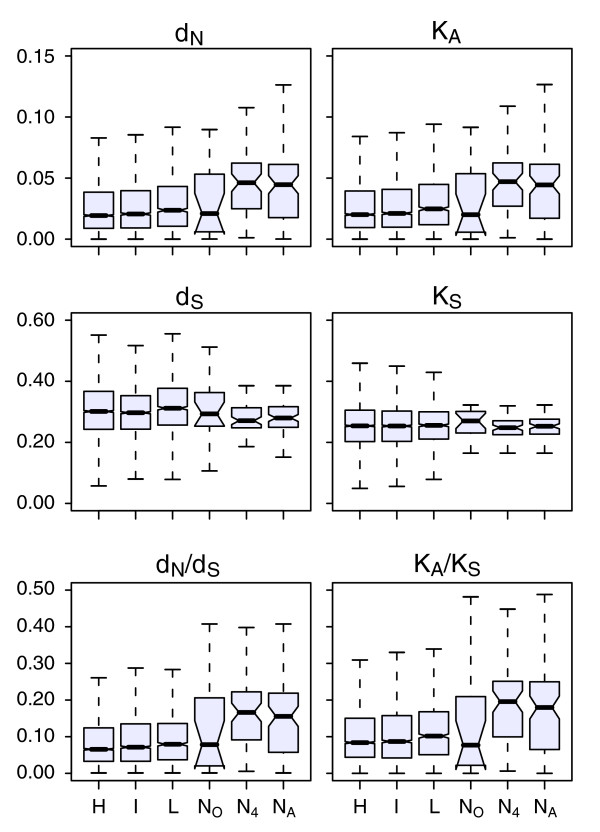
Notched box-plots of dN, dS, dN/dS, KA, KS and KA/KS for each recombination region. Shown are notched box-plots of dN, dS, dN/dS, KA, KS and KA/KS for regions of high (H), intermediate (I), and low (L) frequency of crossing over and regions of no crossing over, divided into non-fourth chromosome genes (NO), fourth chromosome genes (N4), and all no crossing over region genes (NA). The box extends from the lower to the upper quartile, with a line in the middle at the median. The dotted bars represent the 5th and 95th percentiles. The notches represent an estimate of the uncertainty about the medians for box-to-box comparison; when the notches for two samples do not overlap, the medians of the two groups differ at the 5% significance level.